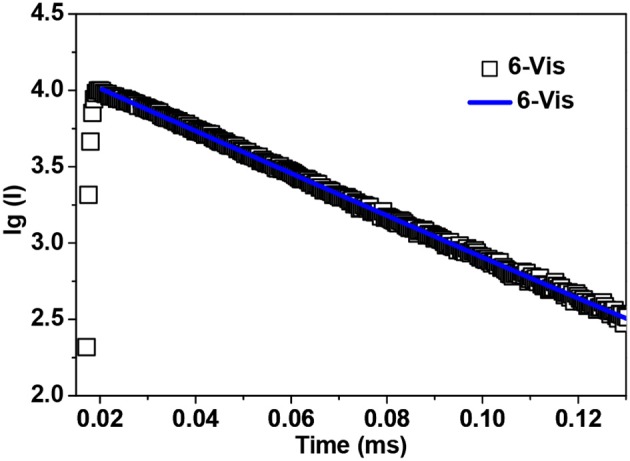
The visible emission lifetime of 6 in CH3CN.